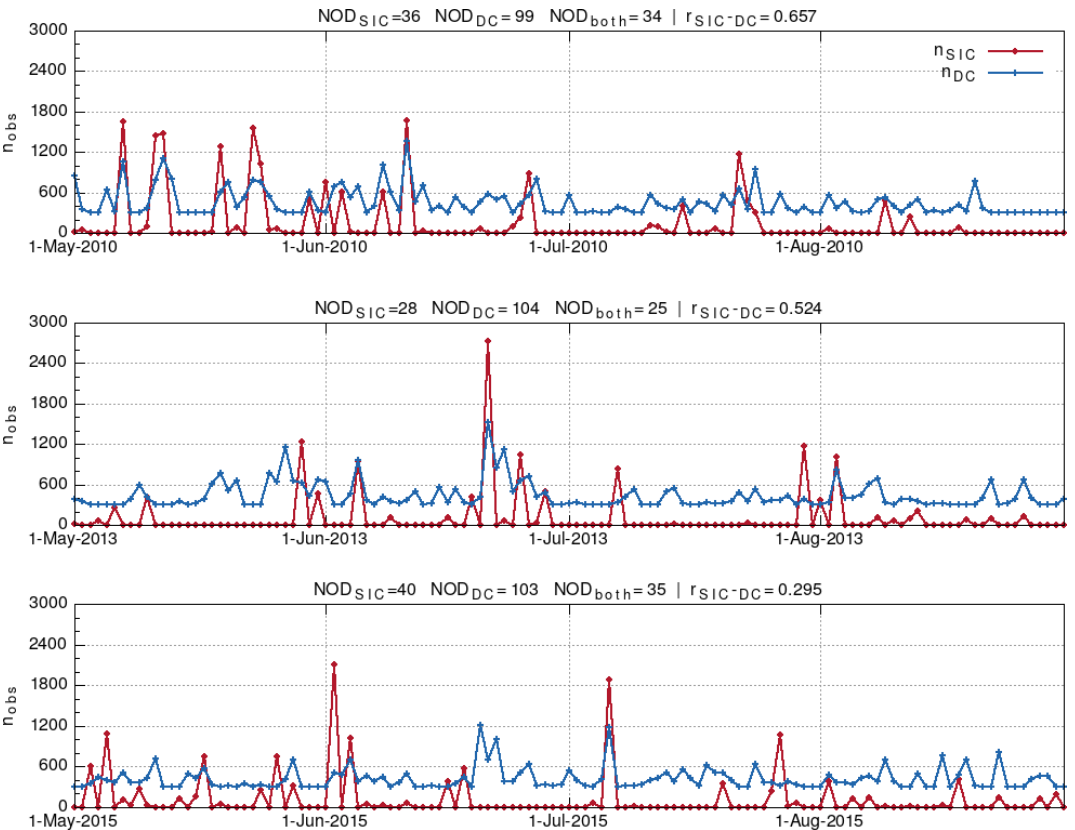
Figure 4. Daily numbers of nighttime observations of SICs (red line with no offset) and deep convection (blue line with offset of 300) over the Midwest United States (35–45 ◦ N, 90–100 ◦ W) in MJJA in 2010, 2013, and 2015. Number of days with occurrences of SICs (NOD SIC ), deep convection (NOD DC ), or both (NOD both ) are counted. Total detection numbers of SICs ( n SIC ), deep convection ( n DC ) on each day, and their Pearson linear correlation coefficients ( r SIC-DC ) are also shown above the